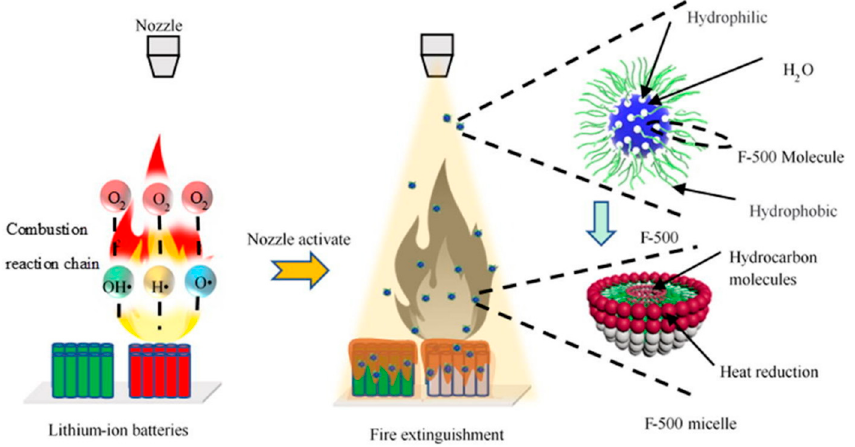
Figure 12. Mechanism of extinguishing battery fire with F500 extinguishing agent [107].